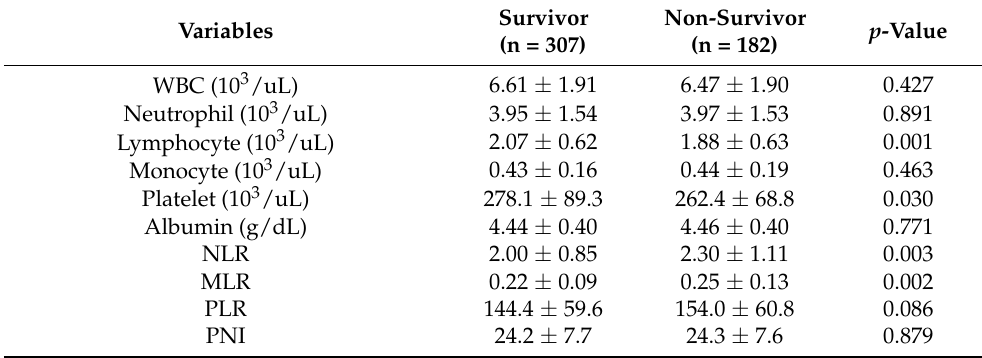
Table 2. Difference among preoperative systemic inflammatory parameters.